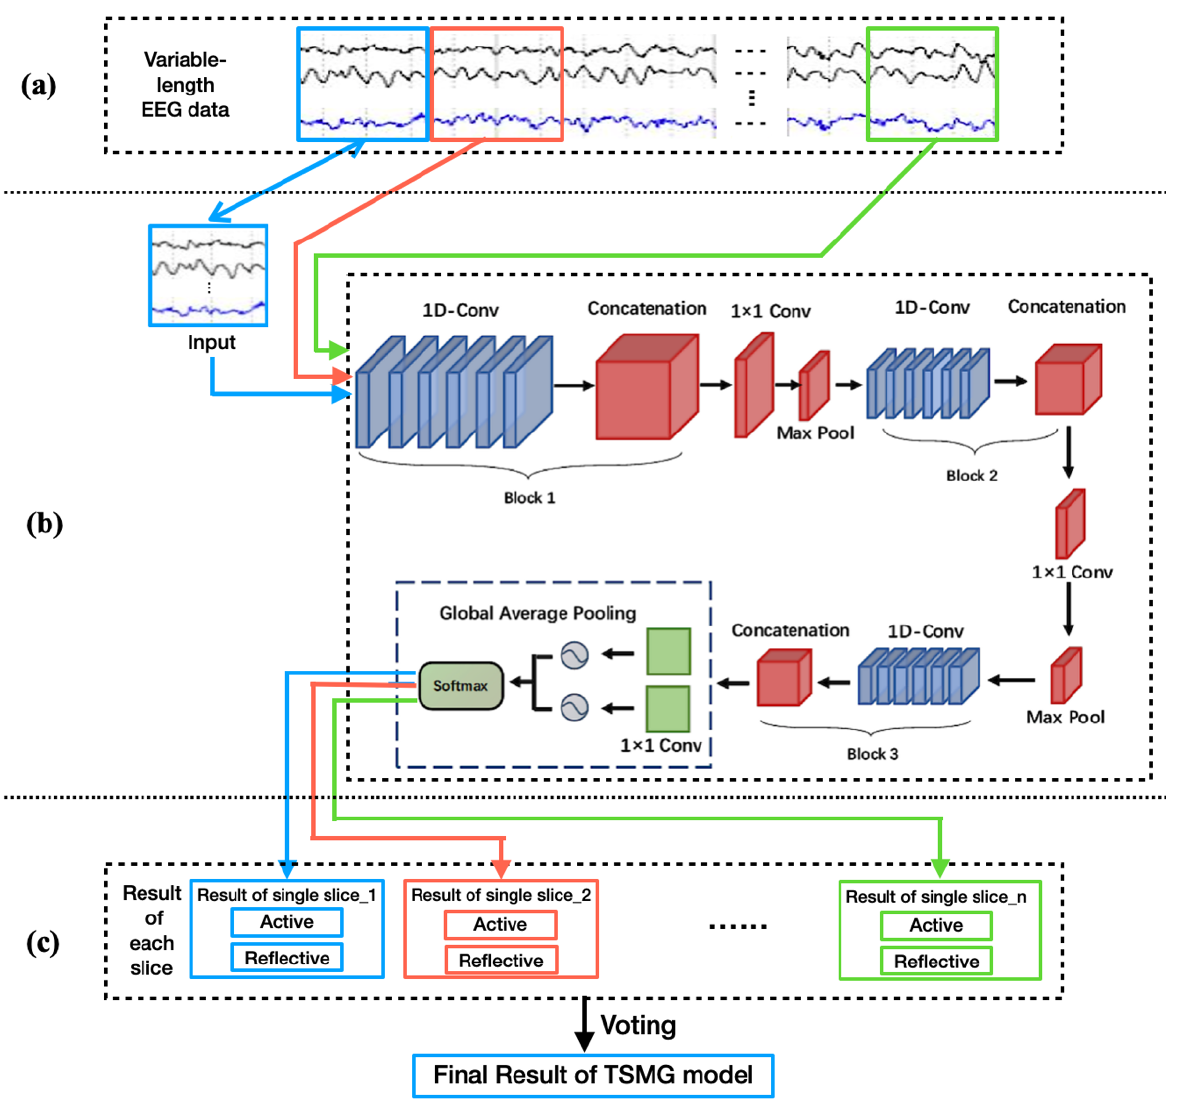
Figure 3. Proposed model to recognize learning styles. ( a ) Non-overlapping sliding window; ( b ) Deep learning modules of TSMG model; ( c ) Group voting mechanism.